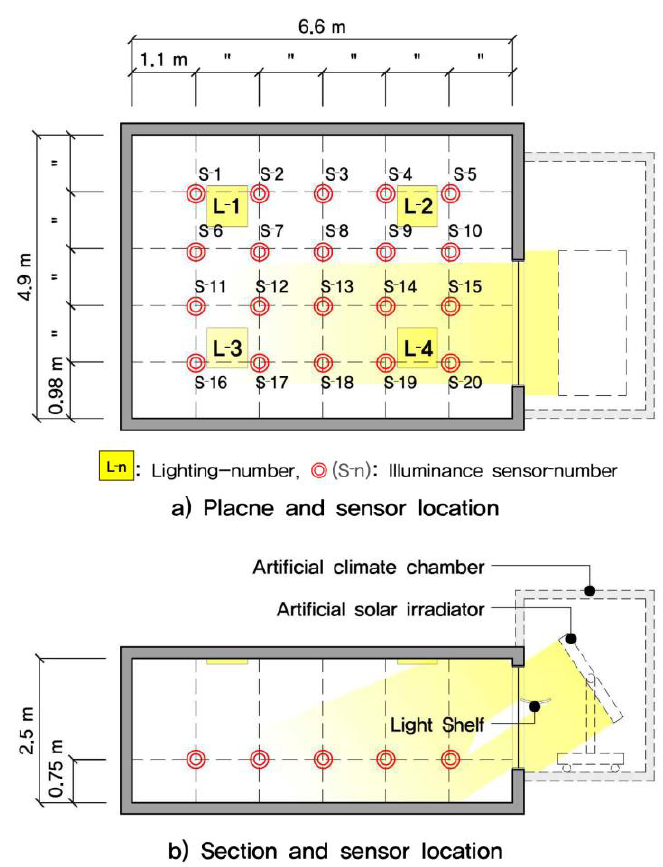
Figure 10. Test bed: section, plane, and sensor locations.